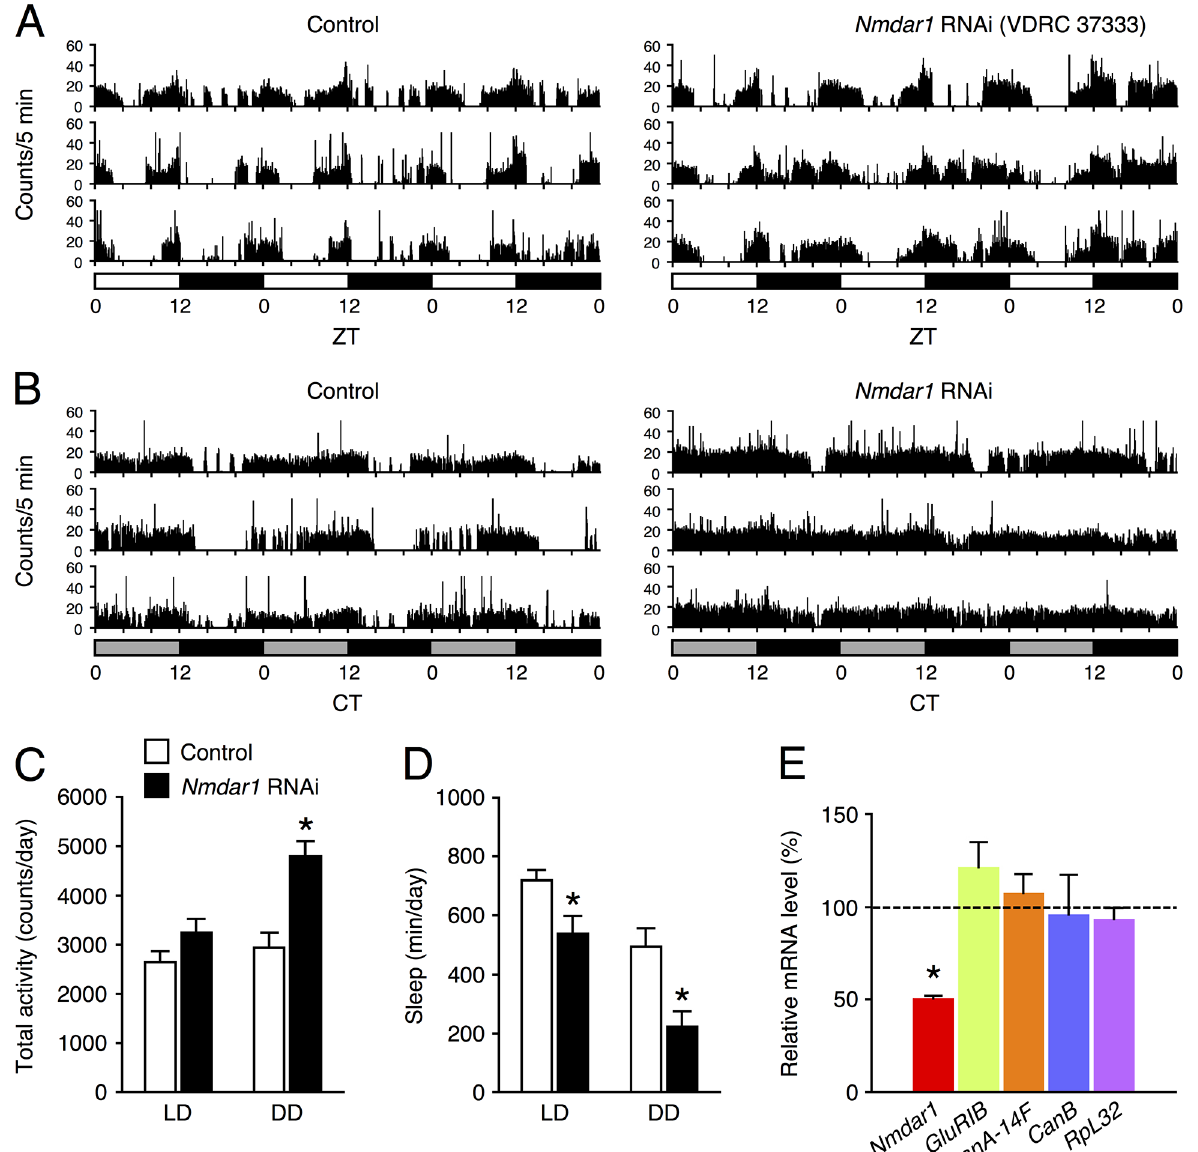
Fig 2. Pan-neuronal Nmdar1 knockdown decreases sleep. (A, B) Locomotor activity profiles for three different control ( elav - Gal4 ; UAS - Dicer - 2 × w 1118 , left panel) and Nmdar1 RNAi (VDRC 37333)-expressing flies using the elav - Gal4 ; UAS - Dicer - 2 driver (right panel) for 3 d in LD (A) and DD conditions (B). White, gray and black bars under the horizontal axis indicate day (ZT 0 – 12), subjective day (CT 0 – 12) and night (ZT 12 – 24 or CT 12 – 24), respectively. Total daily activity (C) and total sleep (D) for control (white bars) and Nmdar1 RNAi flies (black bars) in LD and DD conditions. n = 16 for each group. Data are presented as mean ± SEM. Asterisks indicate statistically significant differences compared to control according to a t -test ( p < 0.05). (E) Efficiency and specificity of Nmdar1 gene knockdown. The expression levels of Nmdar1 , GluRIB , CanA - 14F , CanB and RpL32 genes in the head of male flies expressing Nmdar1 RNAi transgenes in all neurons are expressed as relative values to the control flies. As described in the Materials and Methods, each mRNA level was quantified by qPCR and first normalized to GAPDH2 . Then, the values were normalized to the average of independent control samples, which were set at 100%. Data are presented as mean ± SEM. n = 3 for each group. Statistical significance between control and RNAi flies: * p < 0.05, t